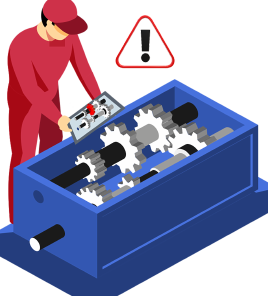
In the Industry 4.0, maintenance operators are supported by augmented reality (AR)-enabled